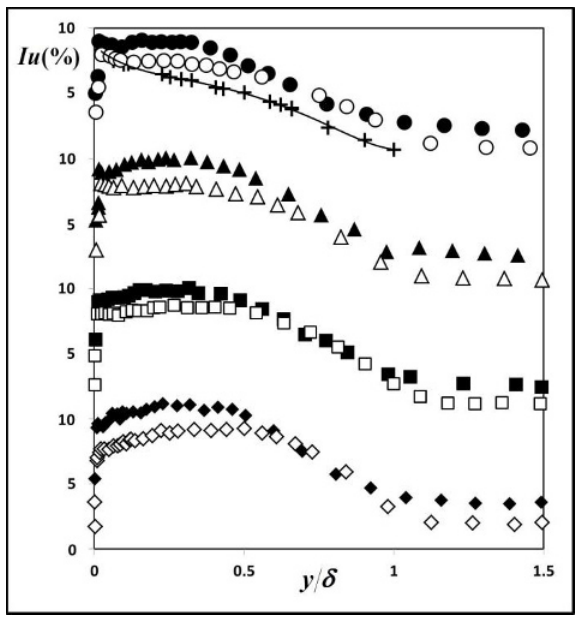
Fig. 9. Profiles of turbulence intensity I u i.e. profiles dimensionless standard deviation of velocity fluctuations normalized by outer variables (full line represents Klebanoff measurements). Symbols are as in figure 7 and additional information is in Table 1.